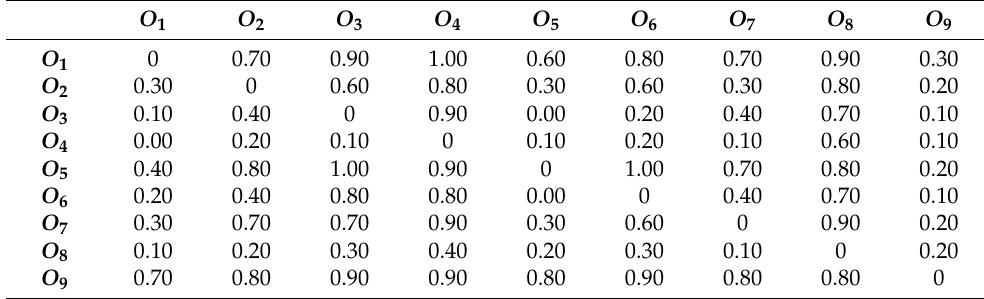
Table 16. Concordance